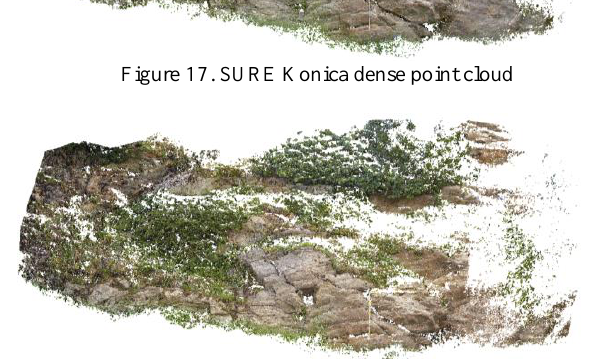
Figure 18. SURE Smartphone dense point cloud